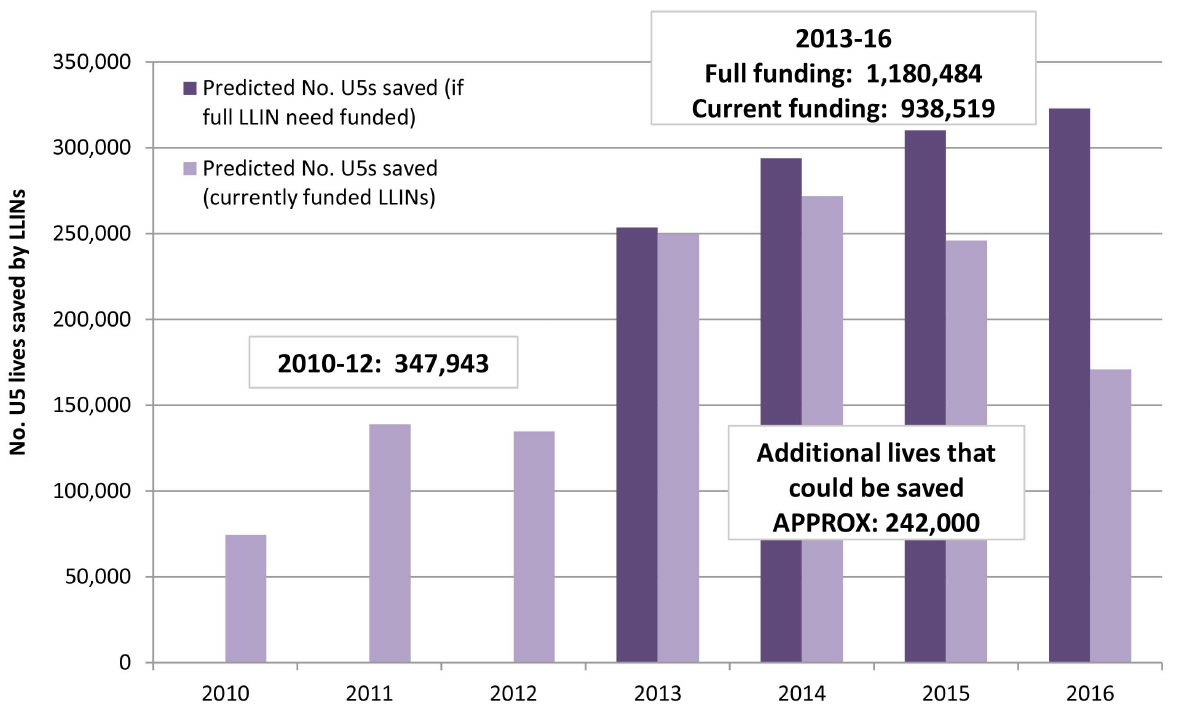
Figure 2. Estimated under-five lives saved with LLINs needed or in the pipeline (2010 – 2016). Estimated number of under-five lives saved with LLINs distributed between 2010 and 2012, and predictions of the lives that could be saved with full funding for all LLINs needed versus currently funded LLINs in 2013-16.